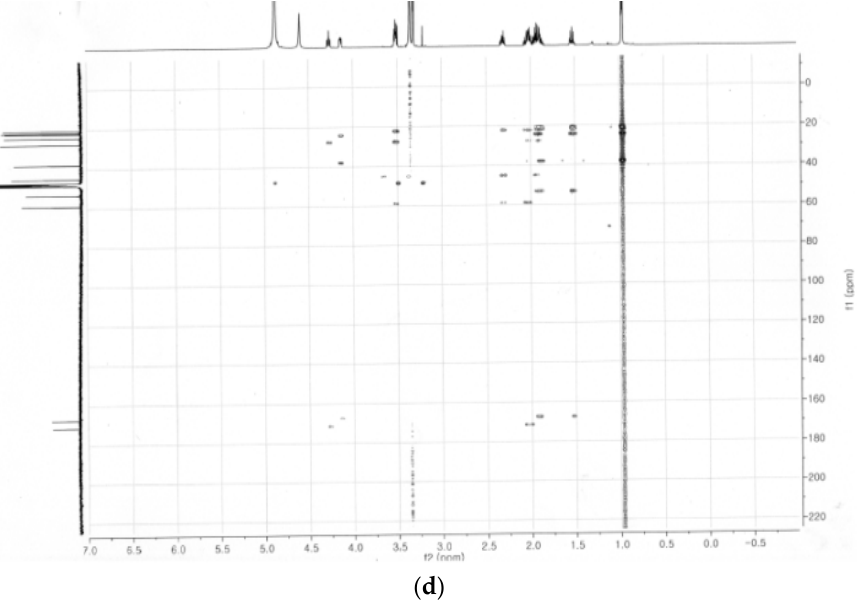
Figure 4. 13 C ( a ) 1H-1H COSY ( b ), HSQC ( c ) and HMBC ( d ) nuclear magnetic resonance (NMR) spectra of the purified compound from B. amyloliquefaciens Y1.